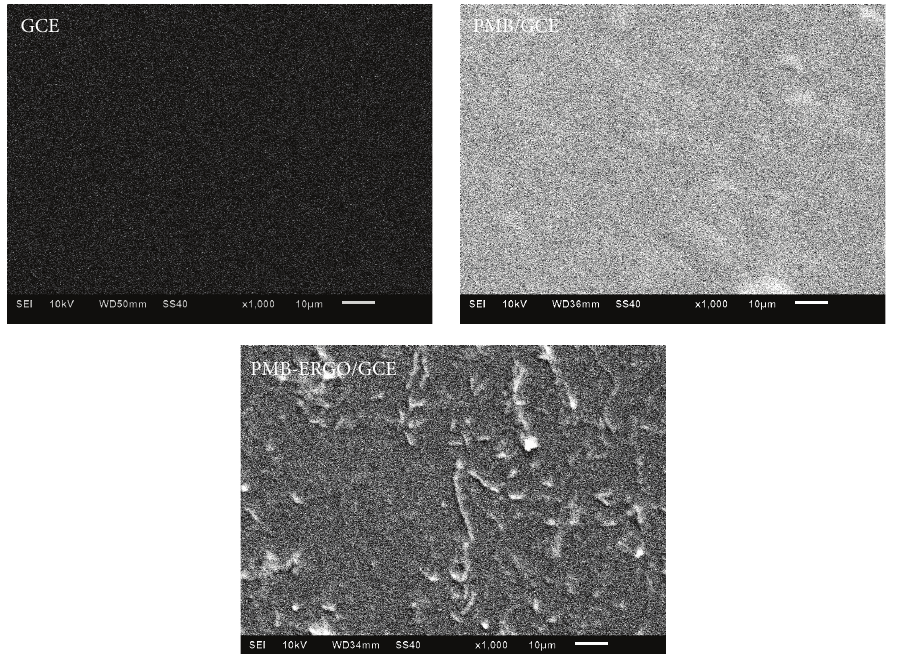
Figure 3: SEM images of GCE, PMB/GCE, and PMB-ERGO/GCE.